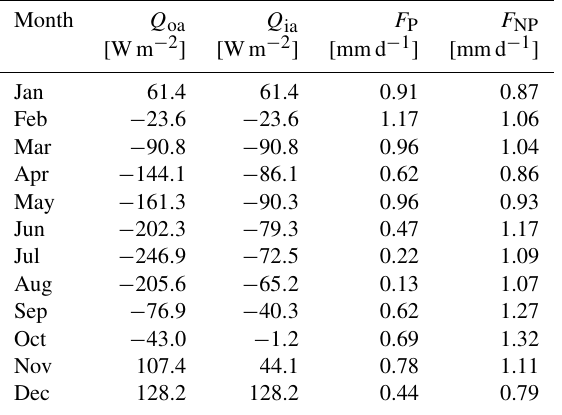
Table 3. Ocean–atmosphere heat flux ( Q oa ; in Wm − 2 ), sea-ice– atmosphere heat flux ( Q ia ; in Wm − 2 ), and the freshwater input ( F = P − E ; in mmd − 1 ) for polynya (P) and non-polynya (NP) regimes per month determined from the CESM simulation of van Westen and Dijkstra (2020a). Positive values represent fluxes going into the ocean or the sea ice (warming and net precipitation). Neg- ative values represent fluxes going to the atmosphere (cooling and net evaporation). All fluxes retained from the CESM simulation are spatially averaged over 2–11 ◦ E × 66.5–63.5 ◦ S.